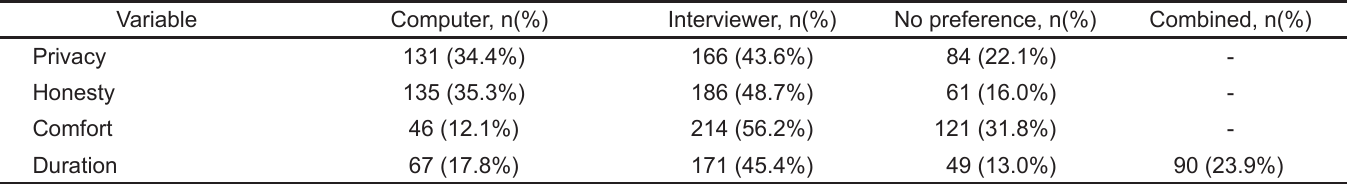
Table 2. Participant preferences for screening modality